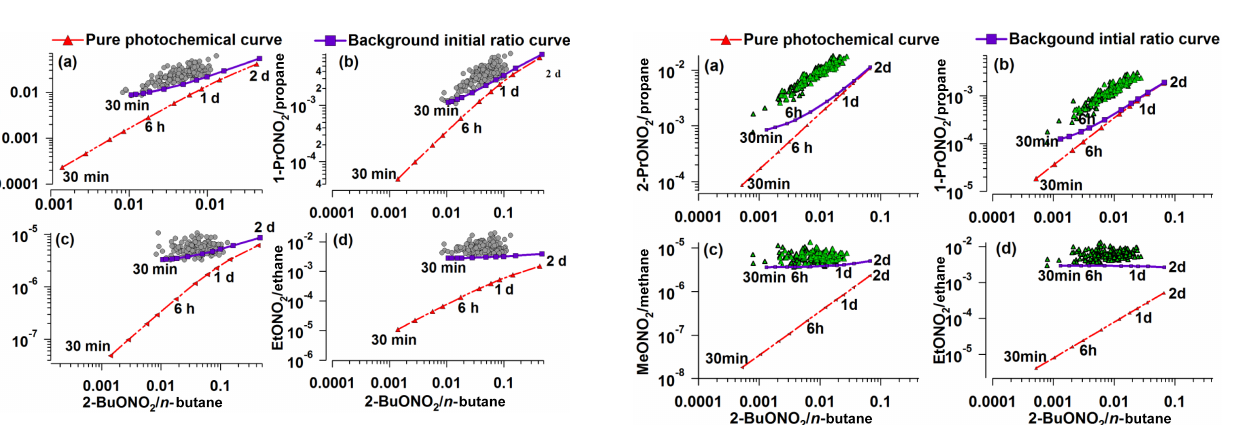
Figure 6. Relationships of C 1 –C 3 RONO 2 / RH with 2- BuONO 2 /n -butane at TW. The red dashed curves were obtained based on zero initial concentrations of RH and alkyl nitrates (pure photochemical curves, PP), while the blue solid curves were ob- tained based on non-zero initial levels (background initial ratio curves, BIR), with the lowest ratios of RONO 2 / RH from 00:00 to